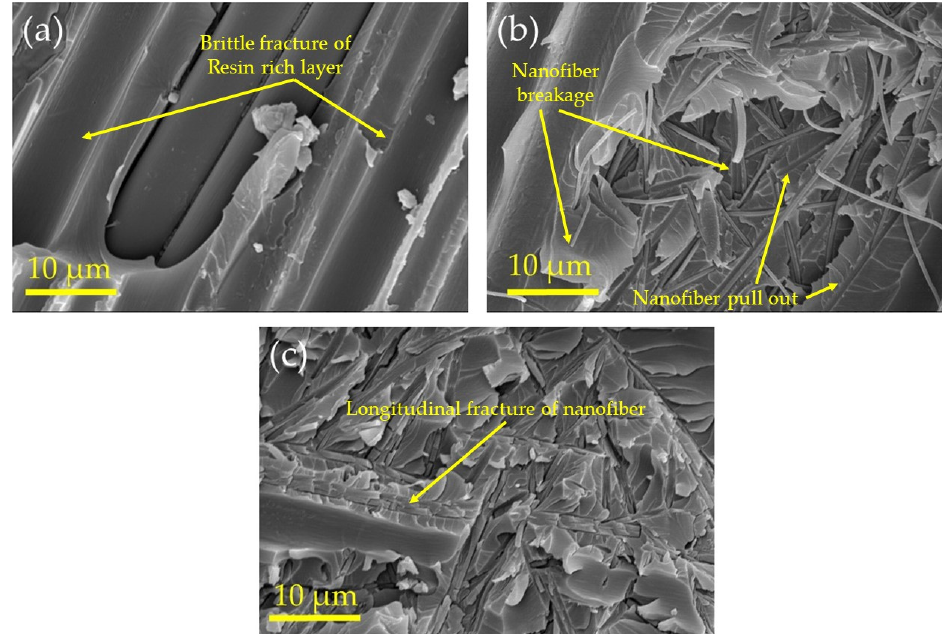
Figure 5. The fractured surface FE-SEM images of ( a ) the control composite, ( b ) reinforced composite interleaving with neat PAN nanofibers, and ( c ) the composite reinforced functionalized PAN nanofibers.